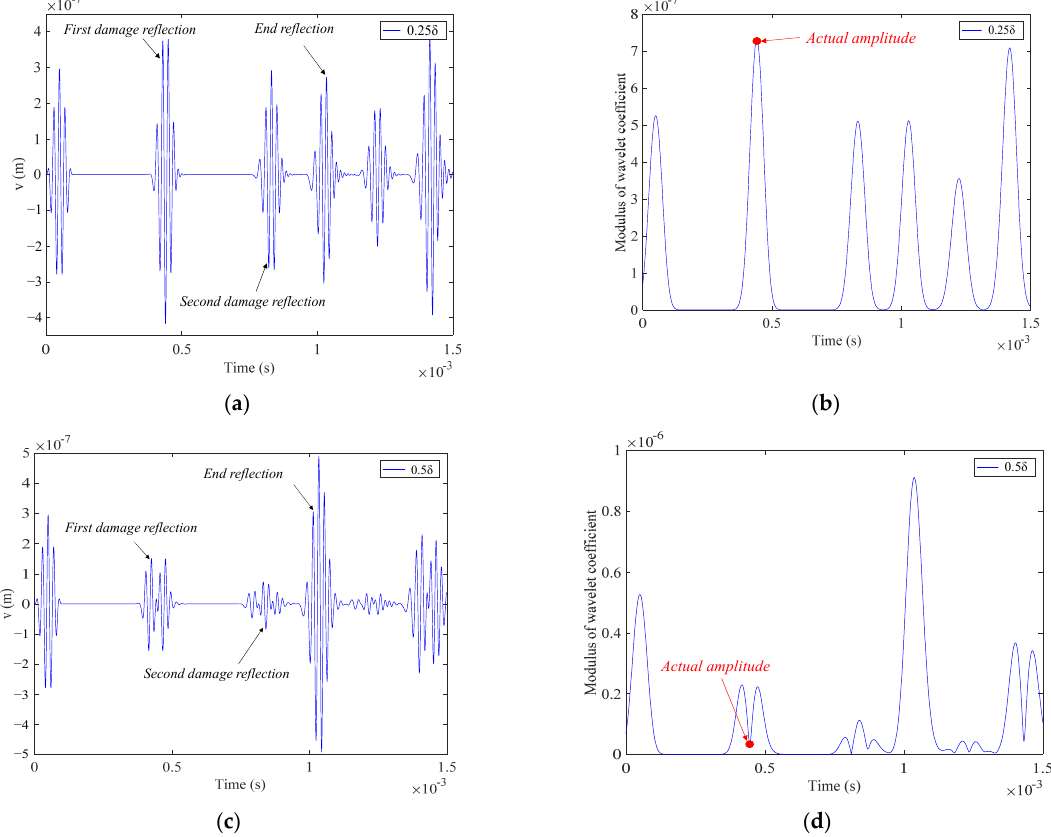
Figure 5. Typical time-domain responses and their corresponding wavelet coefficient modulus for: ( a , b ) the 0.25 δ -wide defect; ( c , d ) the 0.5 δ -wide defect.